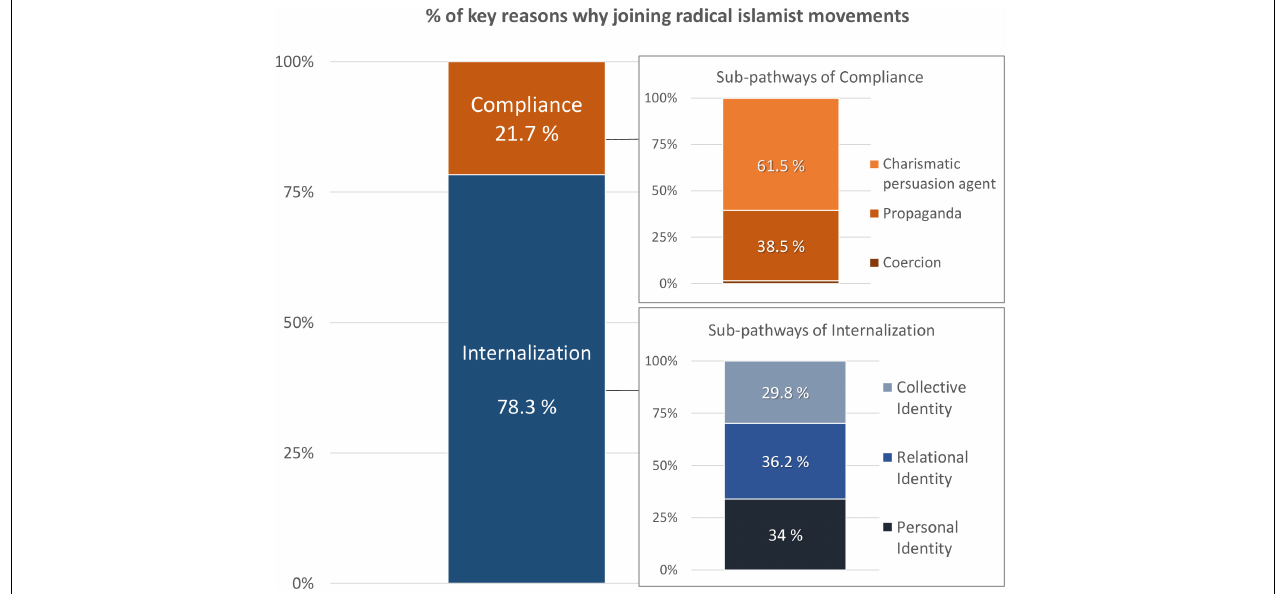
FIGURE 2 | Percent breakdown of key reasons that former members joined Islamist terrorist